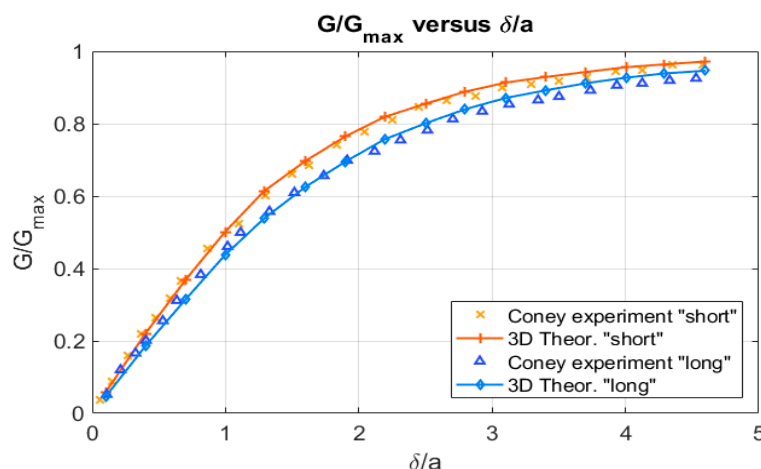
Figure 7. G / G max versus δ / a , for the experiments performed by Coney with the conductance probe, with only one of the electrodes segmented, and long and short electrodes and the results of the calculations with the formulas of Section 2.2.